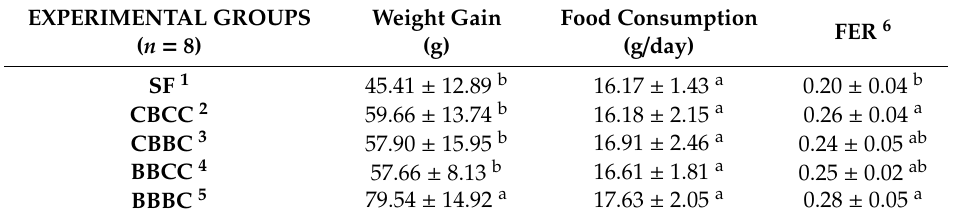
Table 5. Weight gain, food consumption, and food e ffi ciency ratio (FER) of experimental groups.